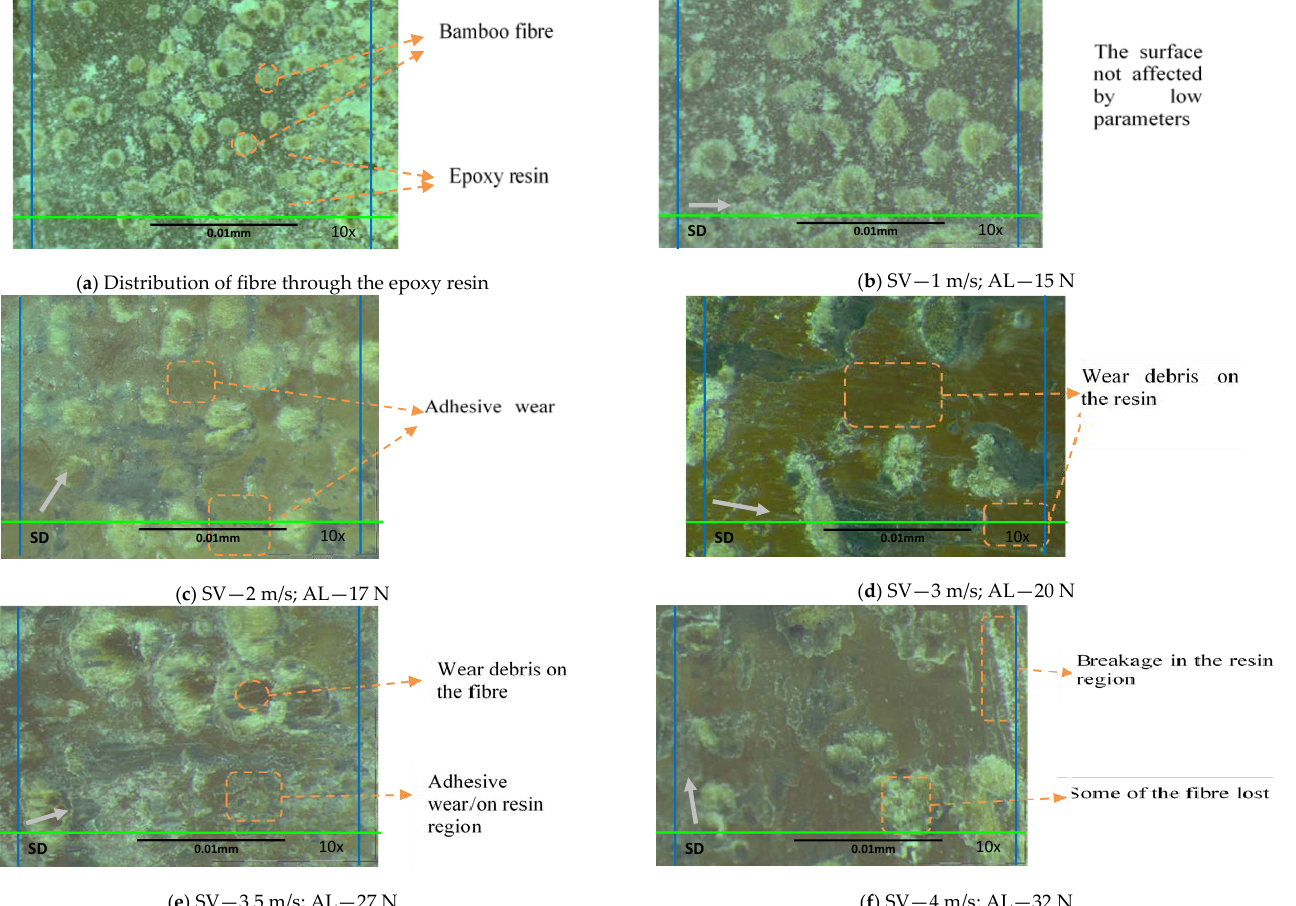
Figure 10. Microscope images showing the morphology of the worn surfaces of the S-BFRE composite test specimen after the tribological test subjected to different operational parameters. Note: SV—Sliding Velocity; AL—Applied Load; SD—Sliding Distance.